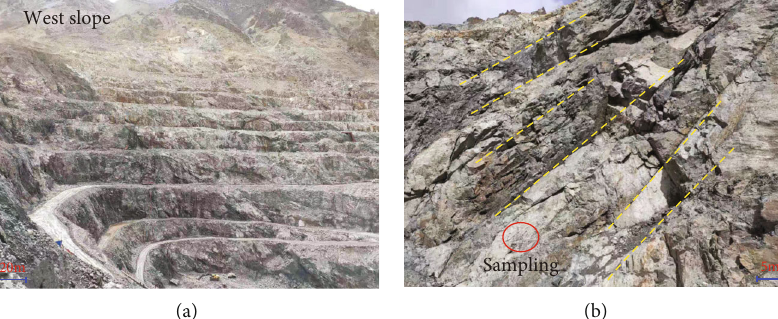
Figure 1: Rock mass structure of the Beizhan open pit slope, a set of dominant structural plane can be observed as drawn in orange